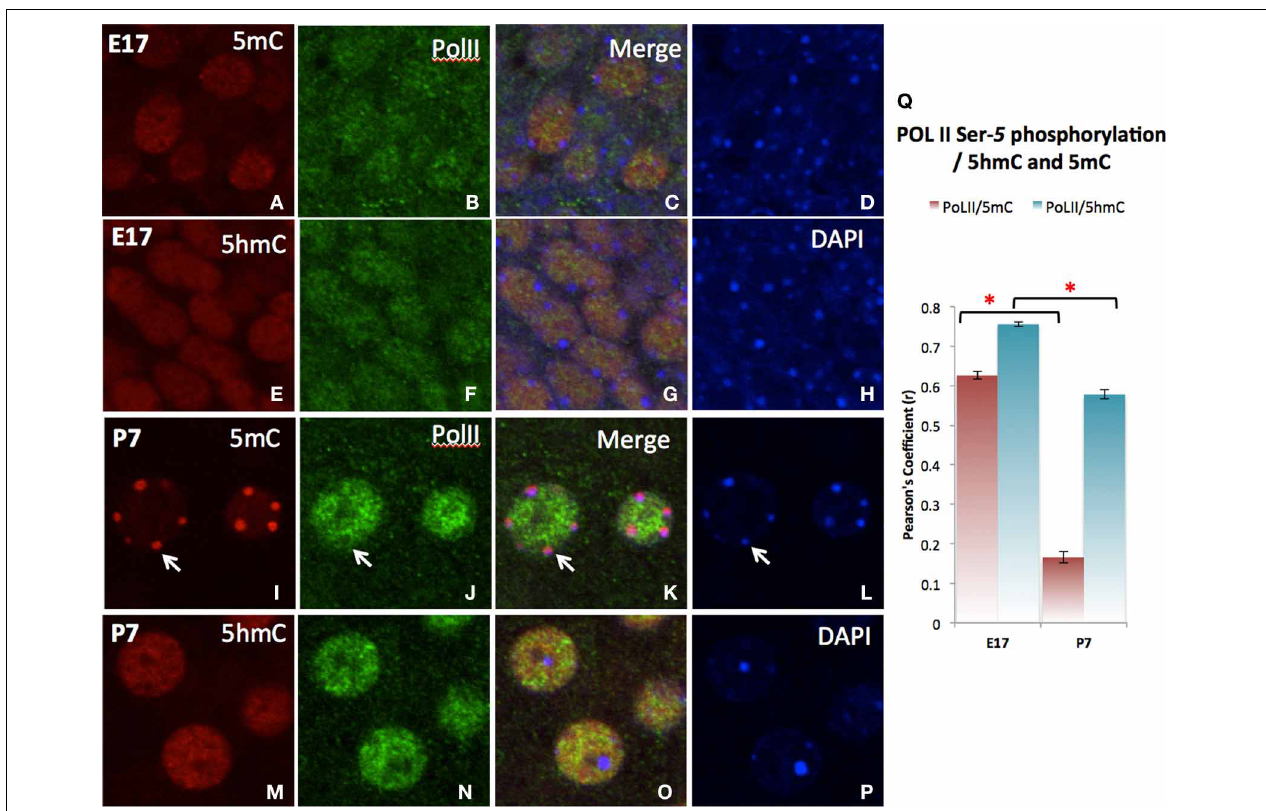
FIGURE 8 | Differential co-localization of Pol II (transcription elongation enzyme) with 5hmC over 5mC in the cortex as demonstrated in confocal microscopy. At stage of early differentiating (E17), both 5mC (A–D) and to a greater extend 5hmC (E–H) are associated the Pol II. As neurons mature (P7), Pol II dissociates with 5mC (I–L,Q , arrows ) , while specifically associates with 5hmC (M–Q) . The 5hmC (red) and Pol II